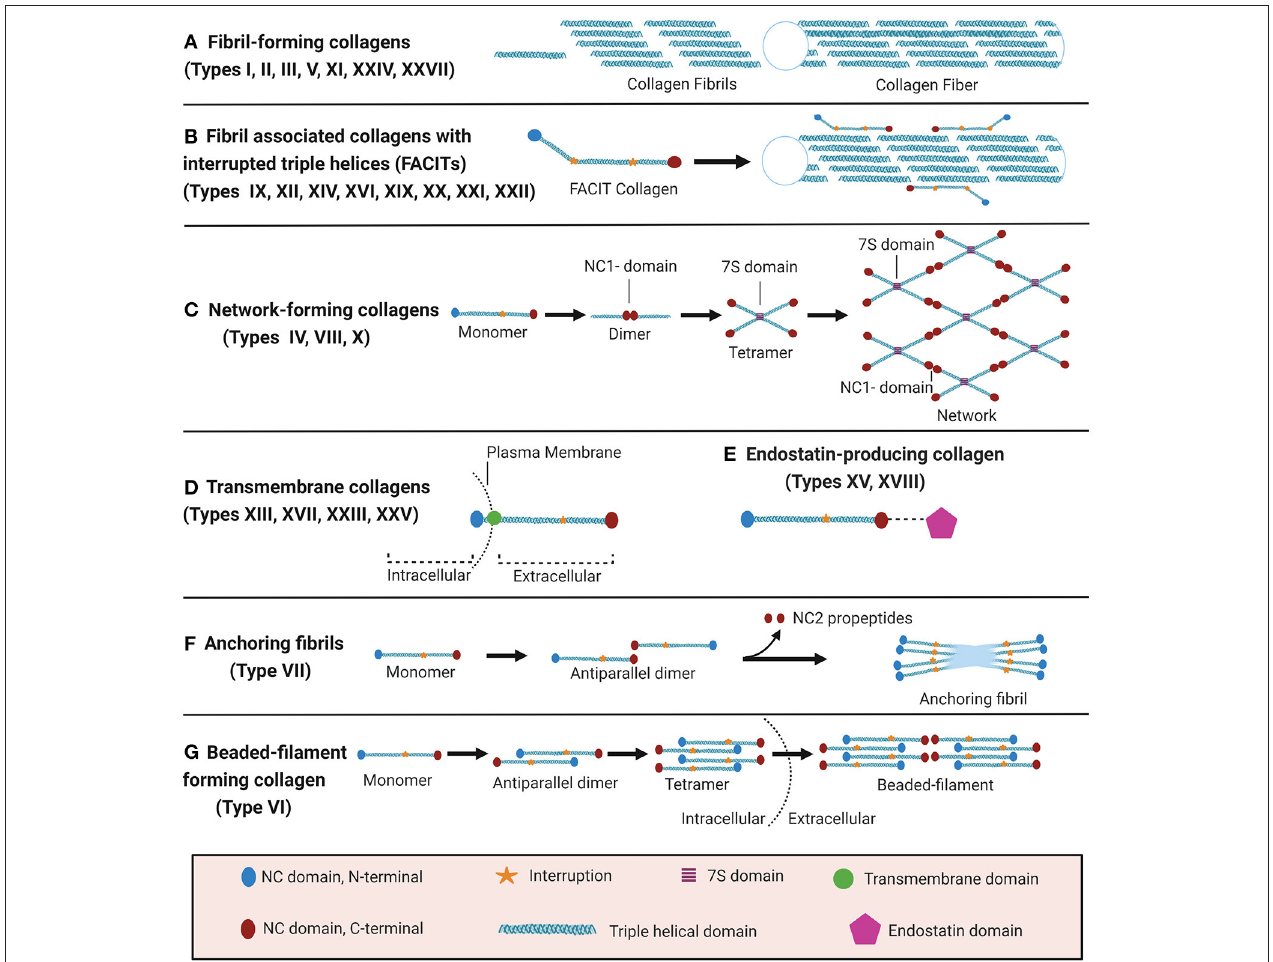
FIGURE 1 | Classification of collagens based on supramolecular assembly. Schematic overview of the major forms of supramolecular assembly of collagen. For some non-collagenous (NC) domains, specific names are established in the literature and therefore specified in the figure: In the collagen IV network (C), the so-called 7S and NC1 domains represent critical nodes. In anchoring fibrils (F), the C-terminal domain which is cleaved off upon fibril formation is termed NC2. Figure was created with